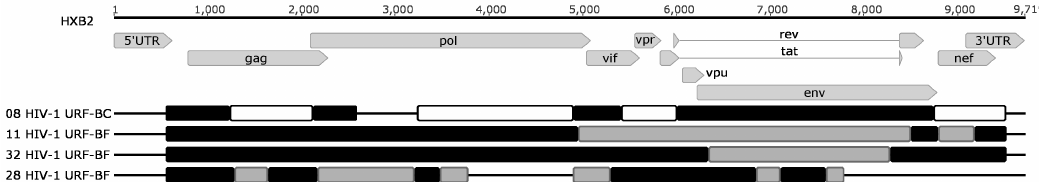
Figure 2. Phylogenetic classification of recombinant viruses considering the phylogeny and similarity analyses. The gray shading patterns represent the different subtypes: black for subtype B, gray for subtype F1 and white for subtype C. Sample IDs are represented at the left of each virus structure, which is in-scale relative to the genomic coordinates of the reference HXB2 genome at the top.